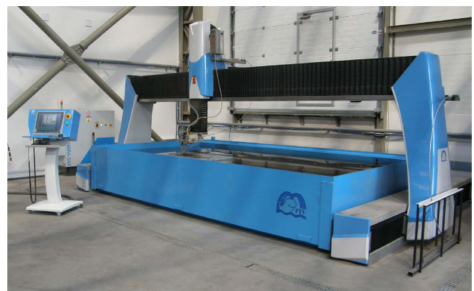
Figure 2. WJ4020 1Z-C0-PJ60 COBRA device.